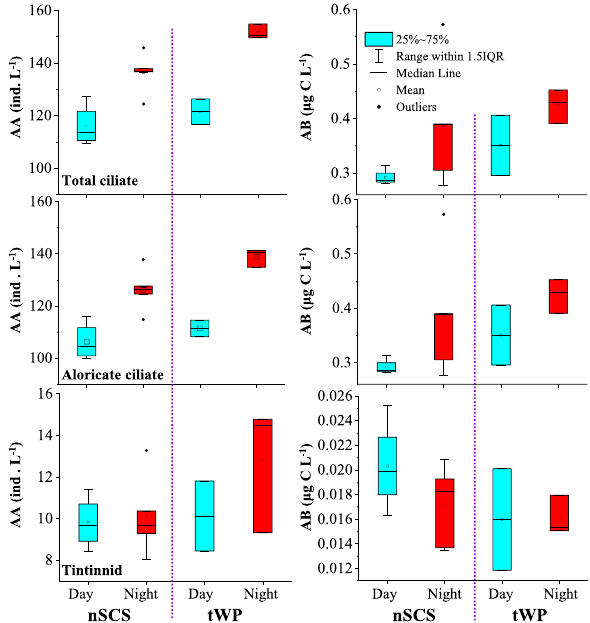
Figure 2. Diel variations of ciliate (total, aloricate ciliate and tintinnid) water column average abundance (AA) and average biomass (AB) in the nSCS and